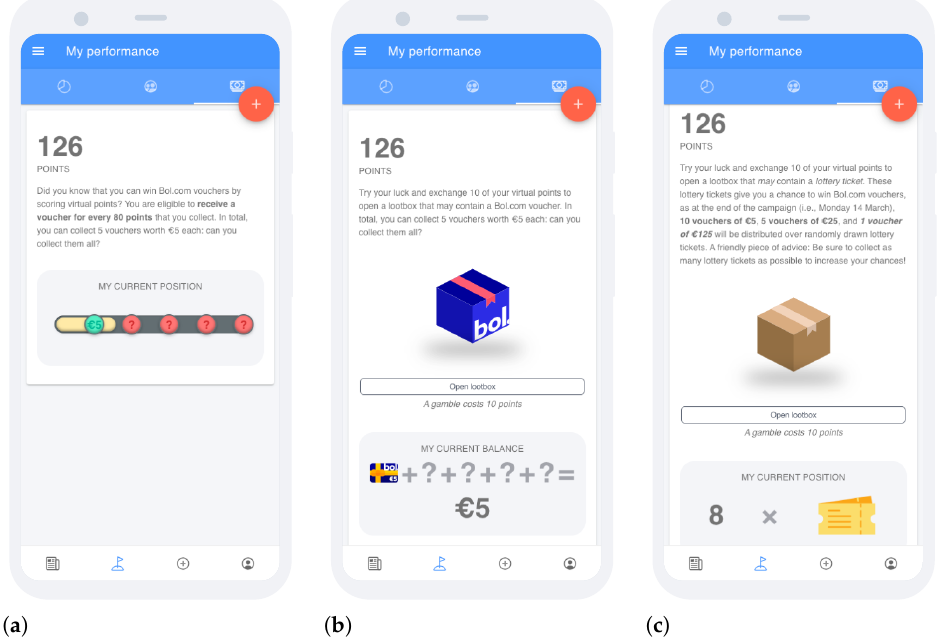
Figure 2. Implementation of different reinforcement schedules that were unique per study arm: ( a ) displays FR-now (i.e., an immediate, fixed ratio schedule), ( b ) displays VR-now (i.e., an immediate, variable ratio schedule), and ( c ) displays VR-delay (i.e., a delayed, variable ratio